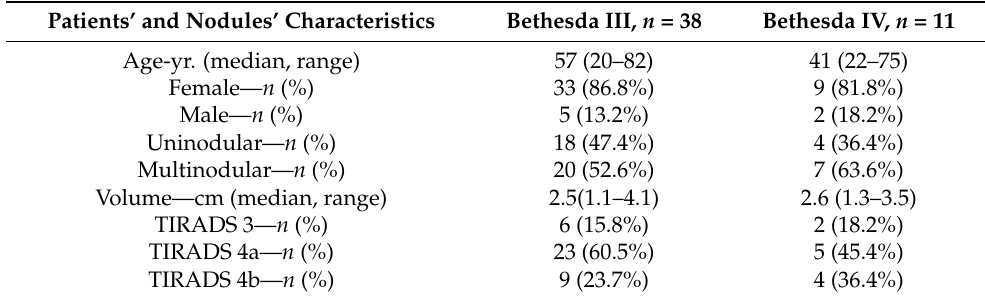
Table 1. The characteristics of the 49 patients with indeterminate cytology included in the present study.